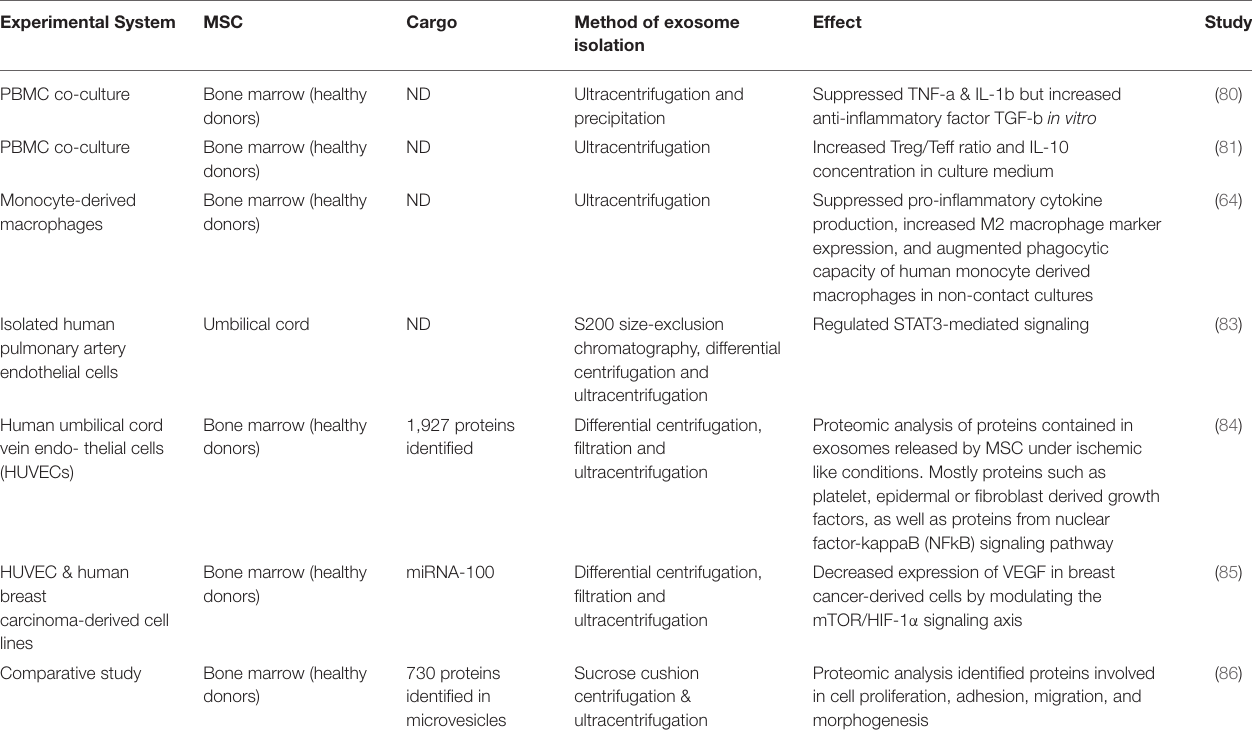
TABLE 2 | Selected studies of MSC-derived exosomes in human models. Experimental System